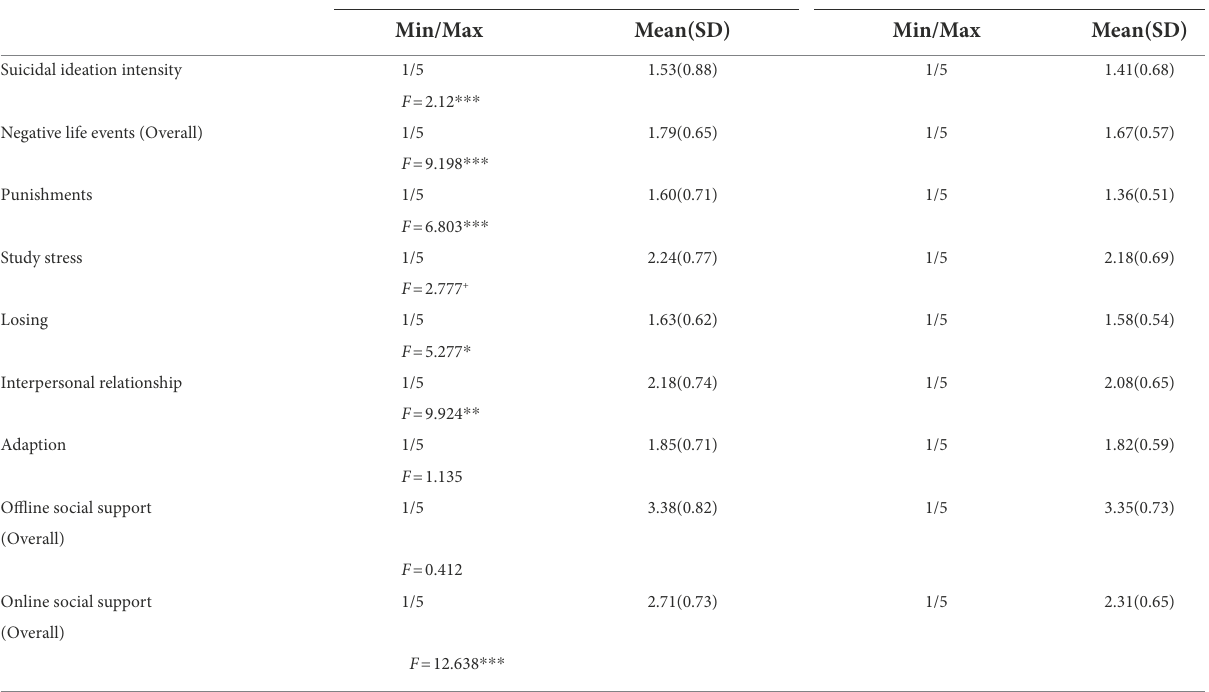
TABLE 2 Descriptive